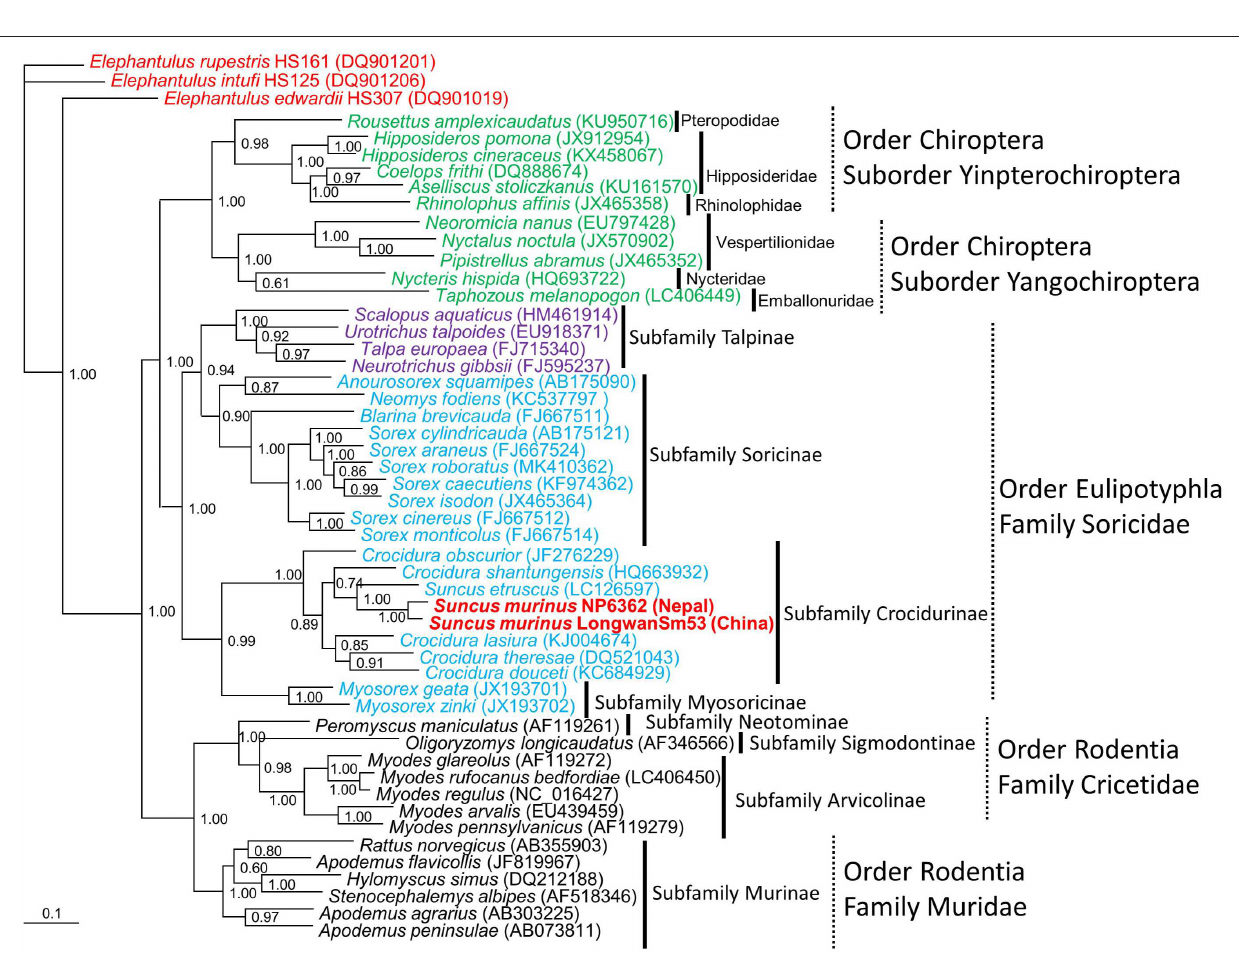
FIGURE 4 | Bayesian phylogenetic tree, based on the 1,140-nucleotide cytochrome b gene of mtDNA of small mammals within the order Eulipotyphla (families Talpidae and Soricidae), order Rodentia (families Muridae and Cricetidae) and order Chiroptera, suborder Yinpterochiroptera (families Pteropodidae, Hipposideridae, Rhinolophidae), and suborder Yangochiroptera (families Nycteridae, Emballonuridae and Vespertilionidae). The tree was rooted using Elephantulus (order Macroscelidea, GenBank accession numbers DQ901019, DQ901206, and DQ901201) as the outgroup. Numbers at nodes indicate posterior probability values ( > 0.7) based on 150,000 trees: two replicate Markov chain Monte Carlo runs, consisting of six chains of 10 million generations each sampled every 100 generations with a burn-in of 25,000 (25%). Scale bars indicate nucleotide substitutions per site. Letterings for taxa are shown in green for bats, blue for shrews, purple for moles, black for rodents, red for Elephantulus, and red bold for Asian house shrew. The GenBank accession number for the cyt b sequence for Asian house shrews are MT344840 in Nepal and JF784169 in